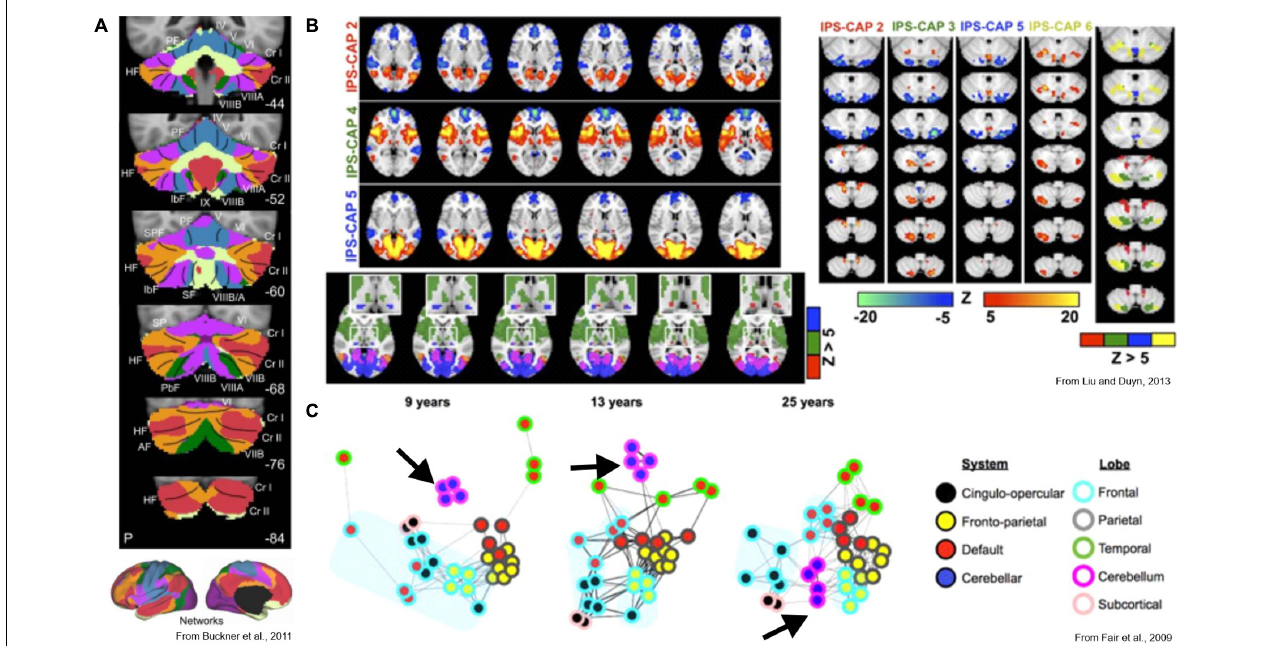
FIGURE 5 | Key functional imaging studies of cerebrocerebellar interaction. (A) Voxel-to-network mapping of cerebellar relationship to cerebral intrinsic networks. Most of the cerebellum is most-strongly linked to association and cognitive cerebral areas. (B) Co-activation pattern analysis identifies recurring spatial patterns of co-activation in the brain. Left: three unique cerebral co-activation patterns involving the intraparietal sulcus are shown. Lower panel shows unique thalamic foci associated with each pattern as well. Right: corresponding cerebellar activations. Focal activation of cerebellar cortex is linked to complex patterns of co-activation across distributed cerebral cortical networks. The non-overlapping foci suggests a voxel-to-network mapping of cerebellar activity to cortical networks is insufficient to describe the cerebellum’s role in distributed brain networks. (C) Maturation of brain networks over the course of development. Black arrow indicates cluster of cerebellar nodes at each developmental stage. Early in development, cortical areas are functionally linked to their nearest anatomical neighbors, and the cerebellum has no functional link to the cortex. Once mature however, the cerebellum acts as a hub between distributed functional networks in cortex.